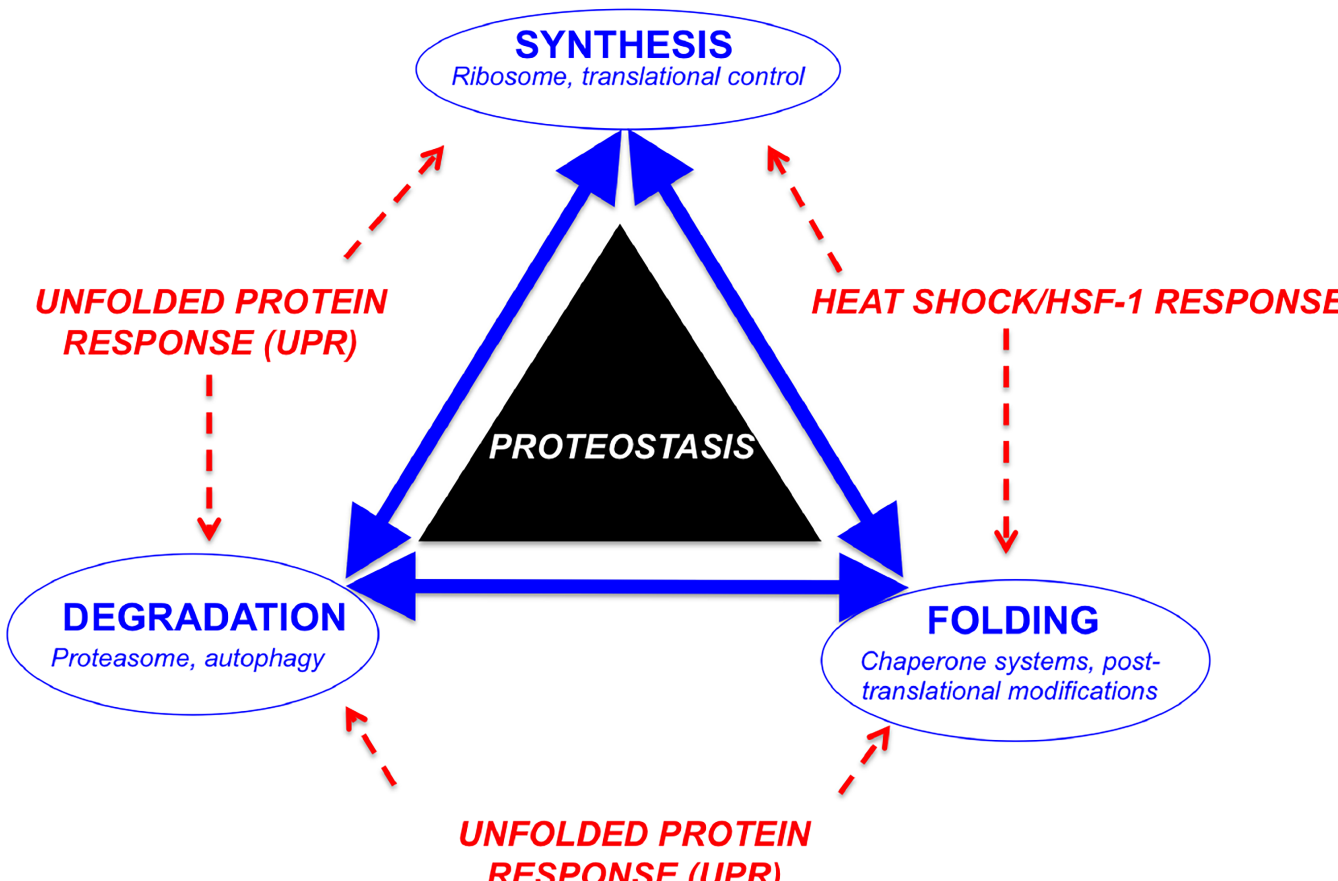
Fig 1. A simplified schematic illustrating the three major functions of the proteostasis network (Blue), and the key modulators (Red), UPR and HSF-1.